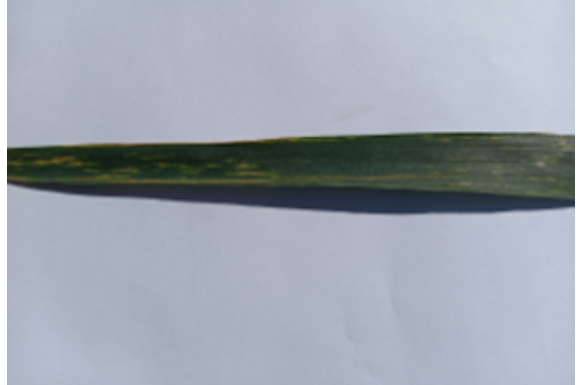
Figure 2. Image sample from the raw dataset.